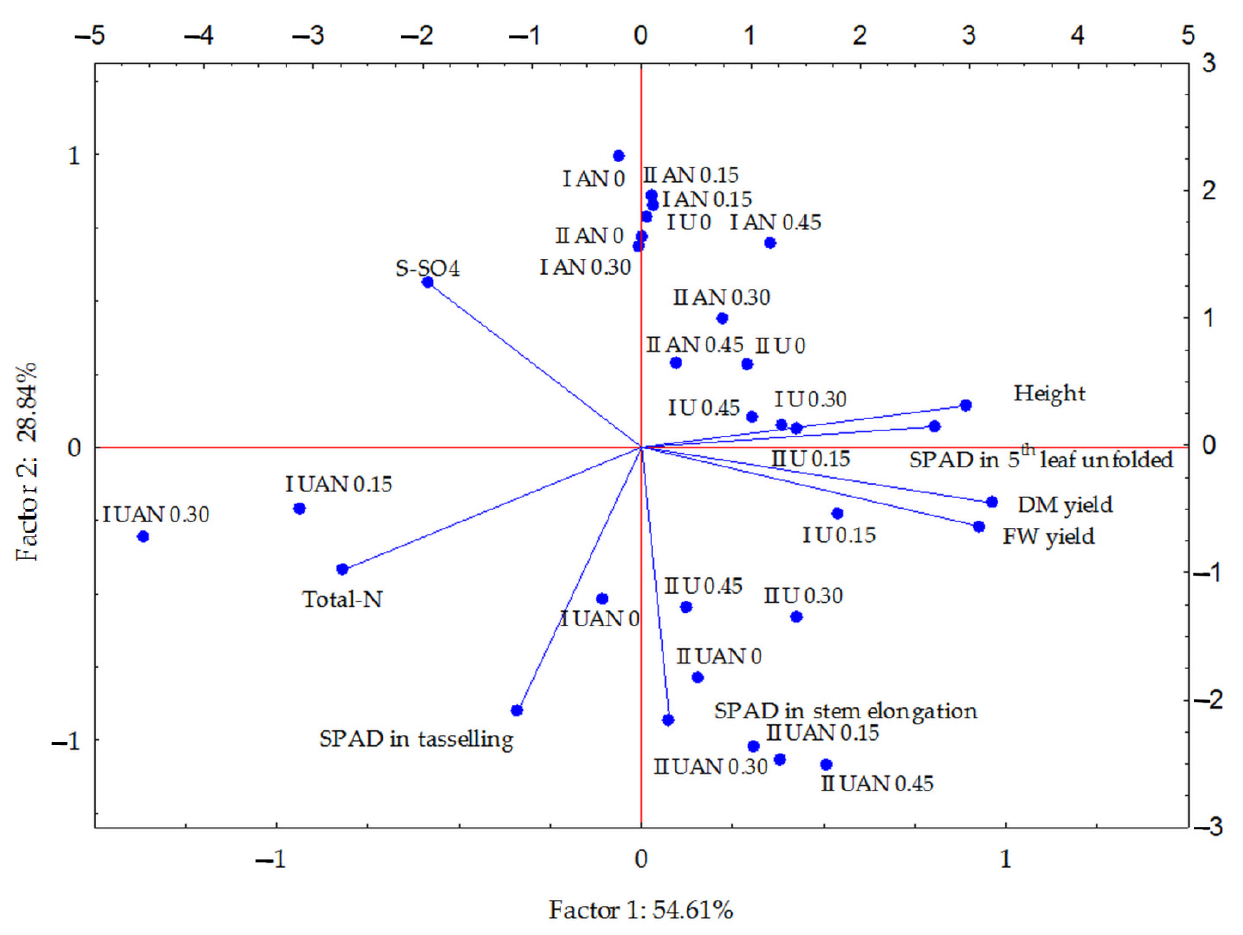
Figure 4. Yield, biometric features, and content of total-N and S-SO 4 in the aerial parts of maize ( Zea mays L.) calculated with the PCA method. Key: vectors represent variables (SPAD in stages of the 5th leaf unfolded, stem elongation, and tasselling; height; aerial parts fresh weight and dry matter yield; content of total-N and S-SO 4 ); points show the samples with elements (I—sand, II—loamy sand; AN—ammonium nitrate, U—urea, UAN—solution of urea and ammonium nitrate; 0, 0.05, 0.10, and 0.15 g humic acid per pot).